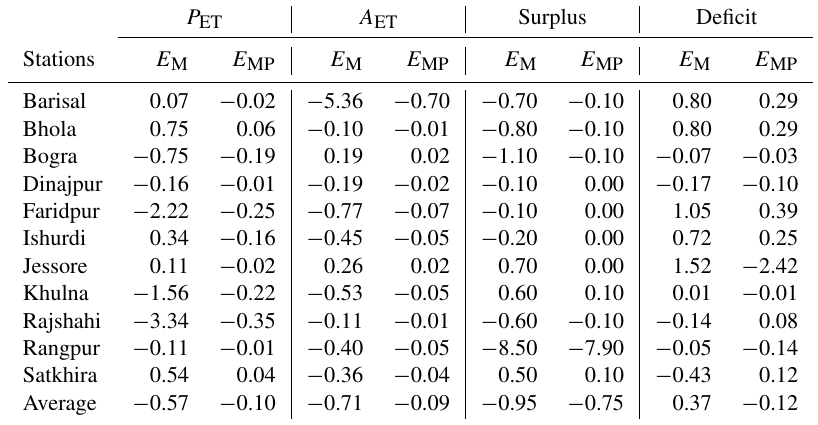
Table 4. Accuracy of WD-ARIMA models of WBCs for validation of the model’s predictive ability for the period of 2009–2010 to 2012– 2013. P ET A ET Surplus Deficit Stations E